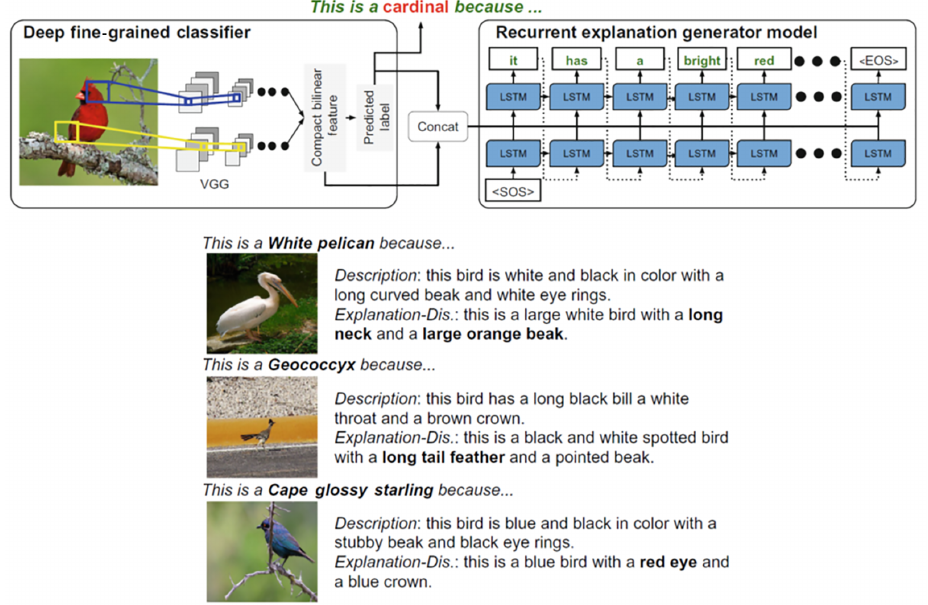
Figure 1. Authors trained a joint classification and explanation network for image classification. The bolded text is a “class-relevant” attribute (a distinguishing attribute for the class) in the explanation. Their classification network extracts visual features (regions on the image) responsible for the decision. Then, the explanation network links these regions to distinguishing words in a dictionary to form an explanation that explains the reason for the classification and why it does not belong to other classes. This level of explanation may be difficult to achieve for hydrologic problems due to limited supervising data (annotated dictionary for classes), but it is possible to borrow the idea of associating features in the input data with some descriptive words (Hendricks et al.,